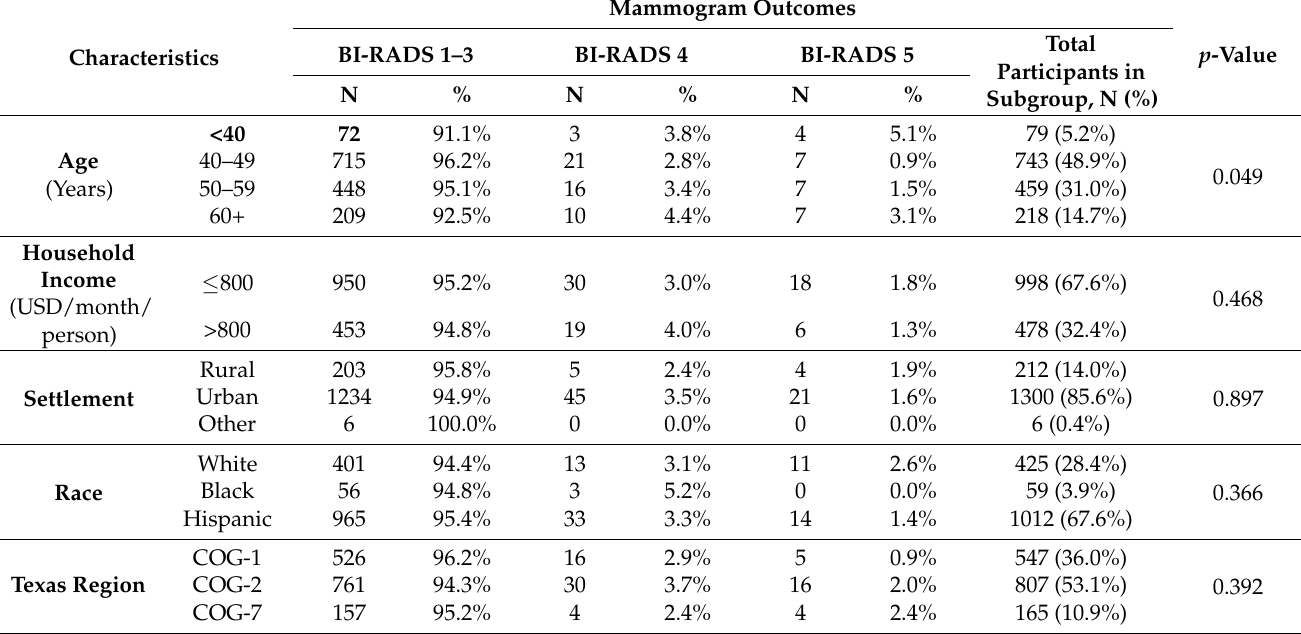
Table 3. Factors associated with “abnormal mammogram